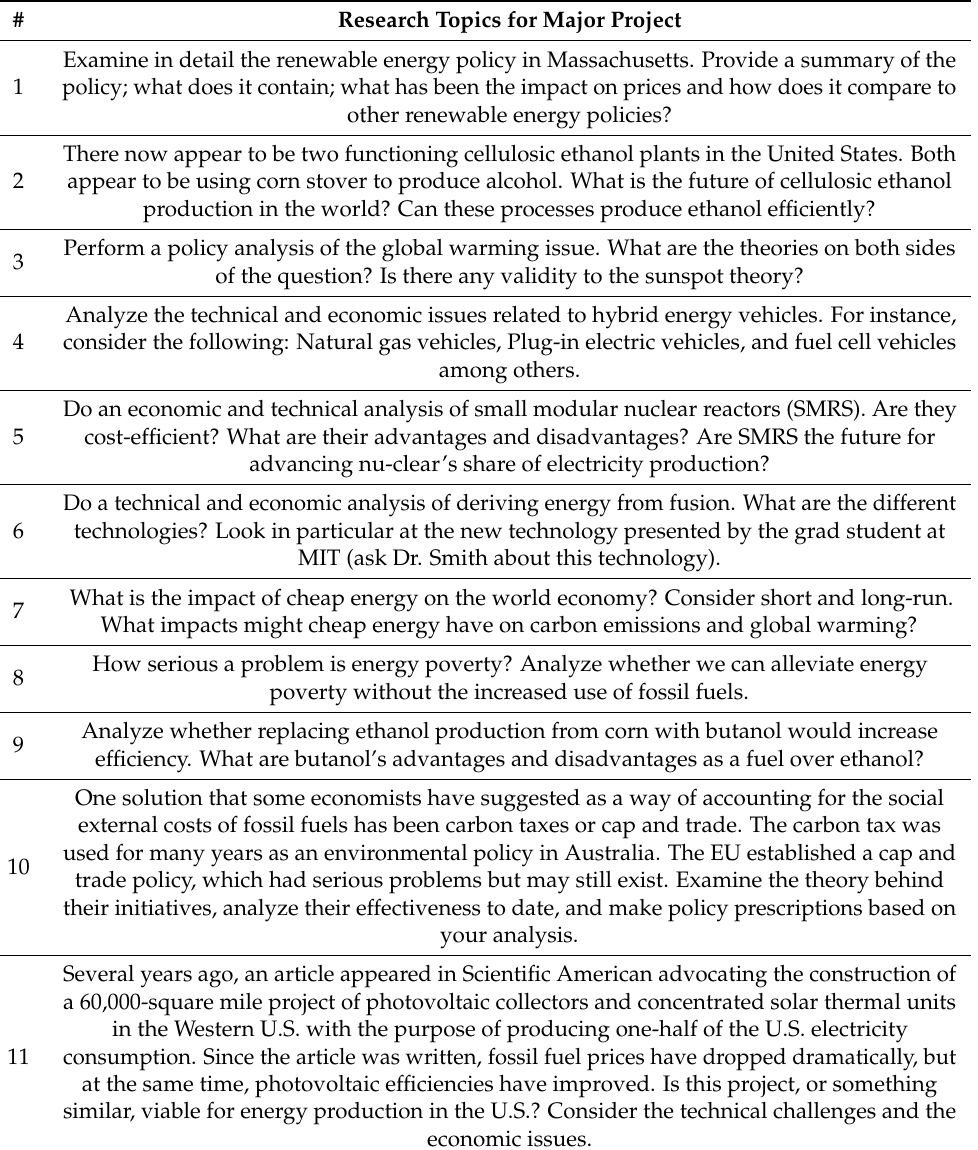
Table 3. Research topics for the major class